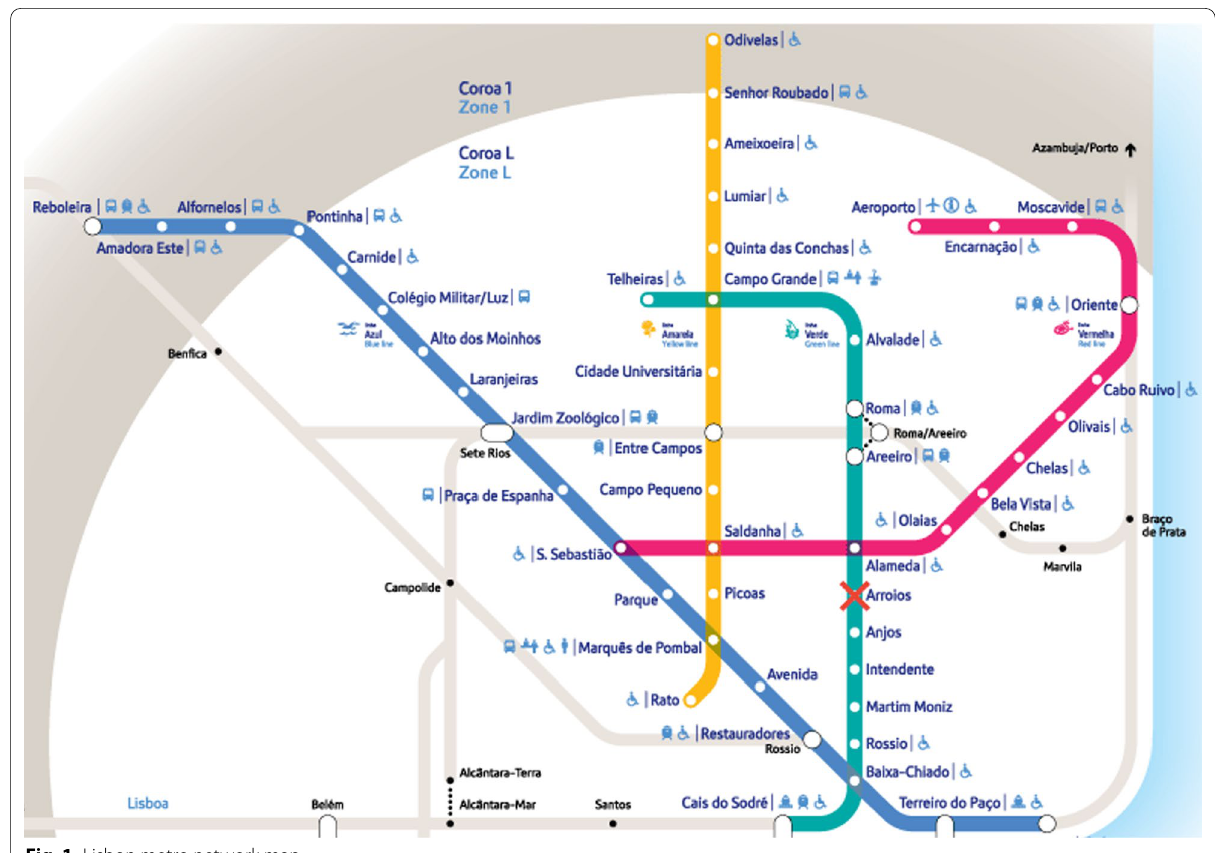
Fig. 1 Lisbon metro network